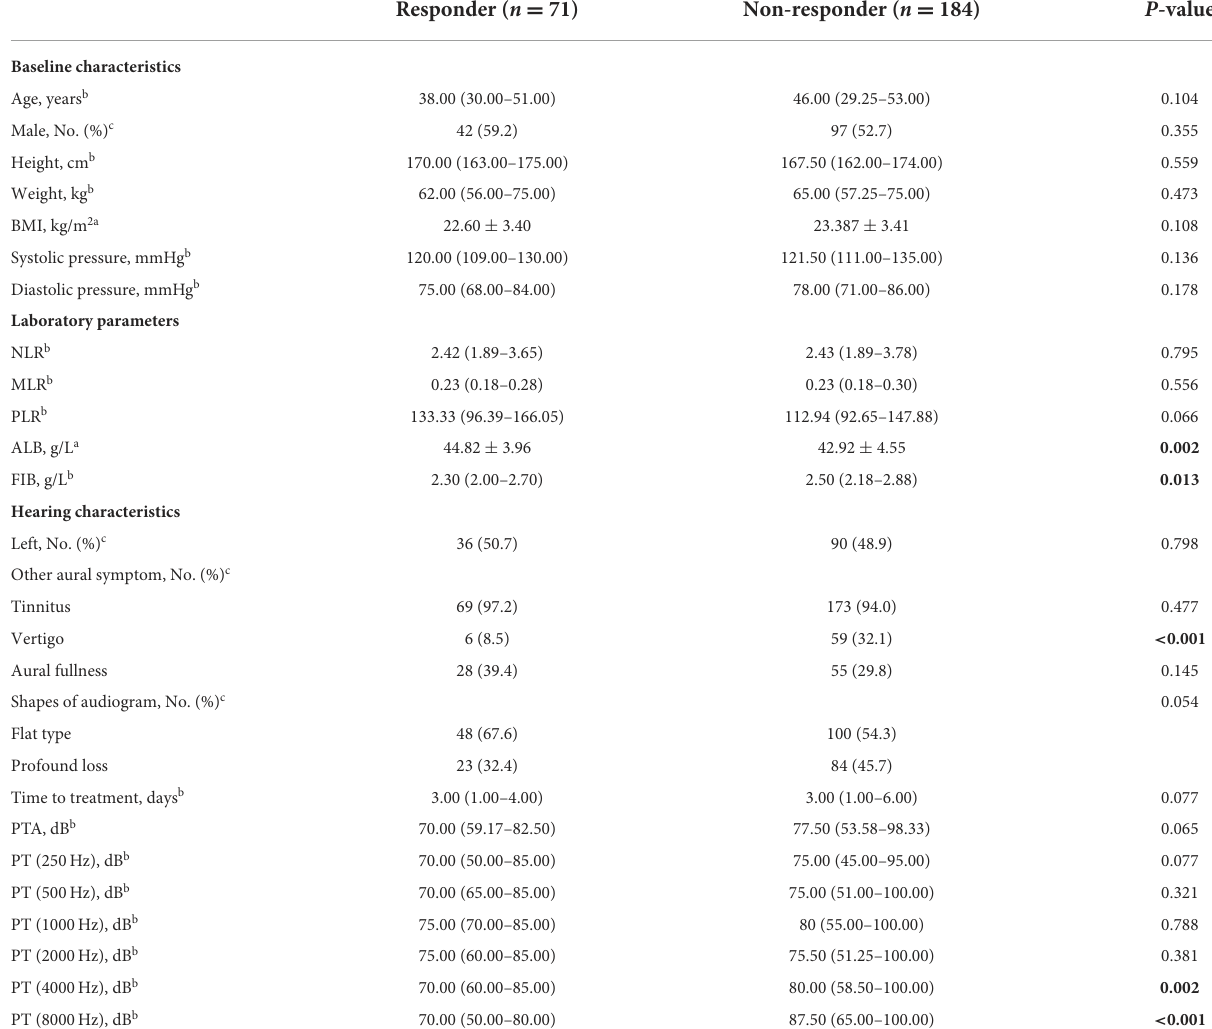
TABLE 2 Comparison of prognosis between responder and